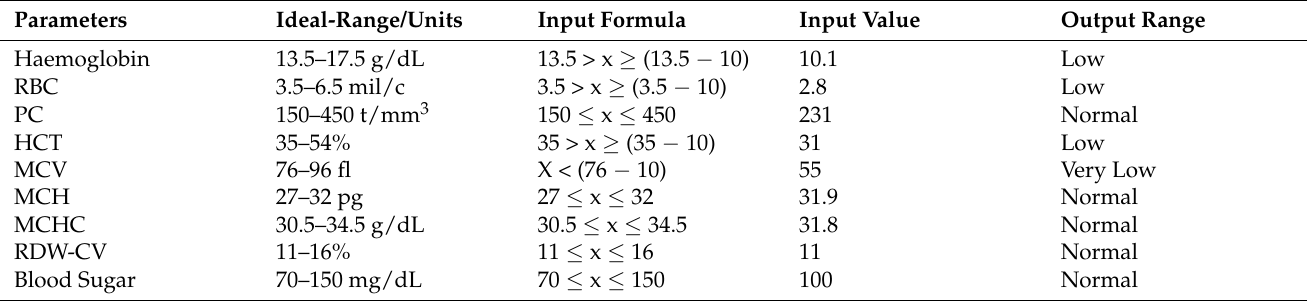
Table 8. Patient Blood Report 1.